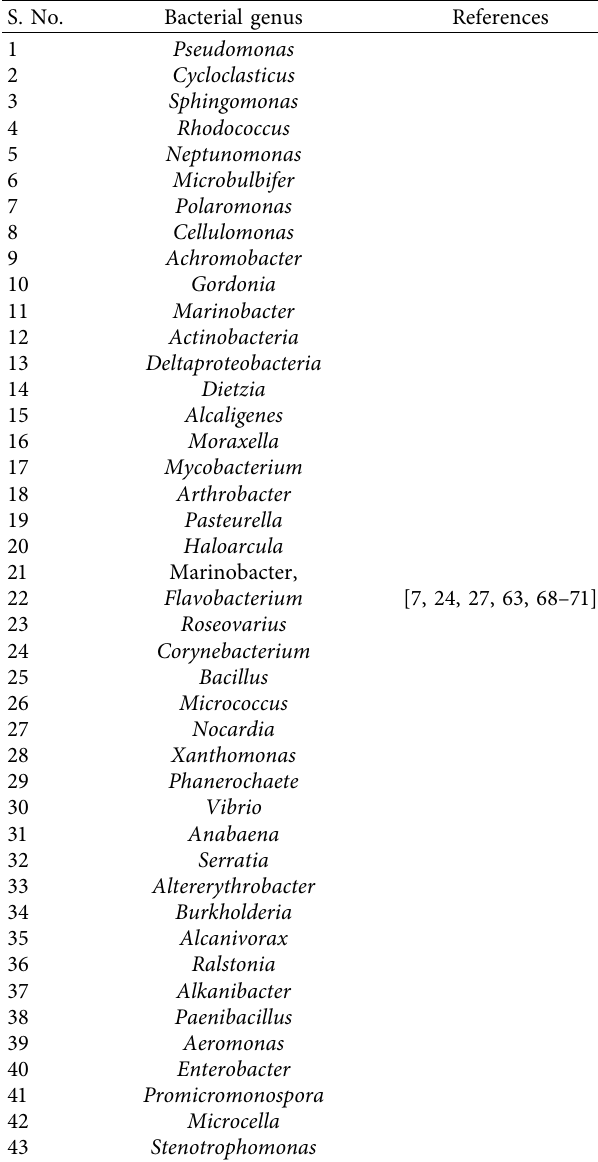
Table 2: Bacterial genus reported for hydrocarbon